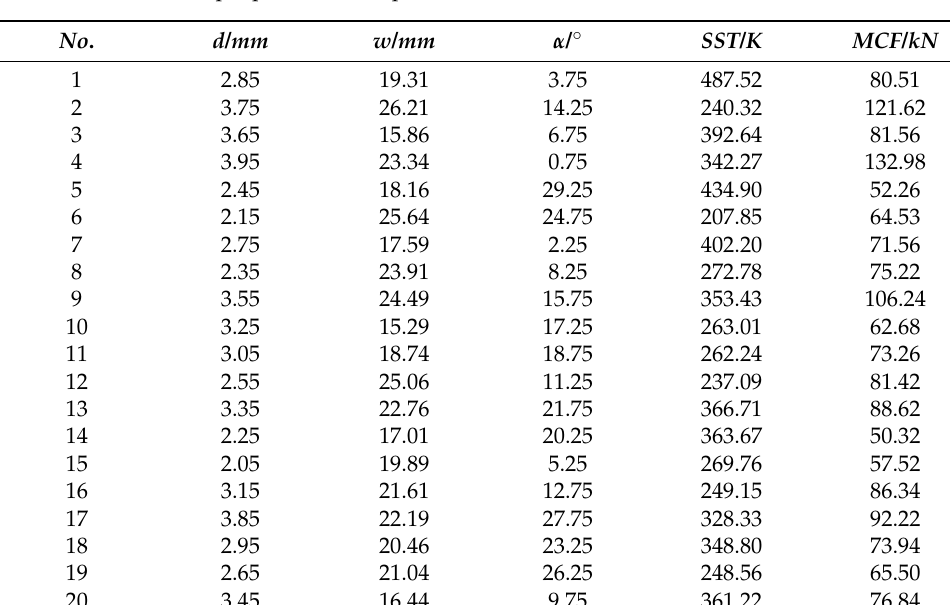
Figure 13. Schematic diagram of the spatial distribution of sample points. Table 3. LHD test sample points and responses values.